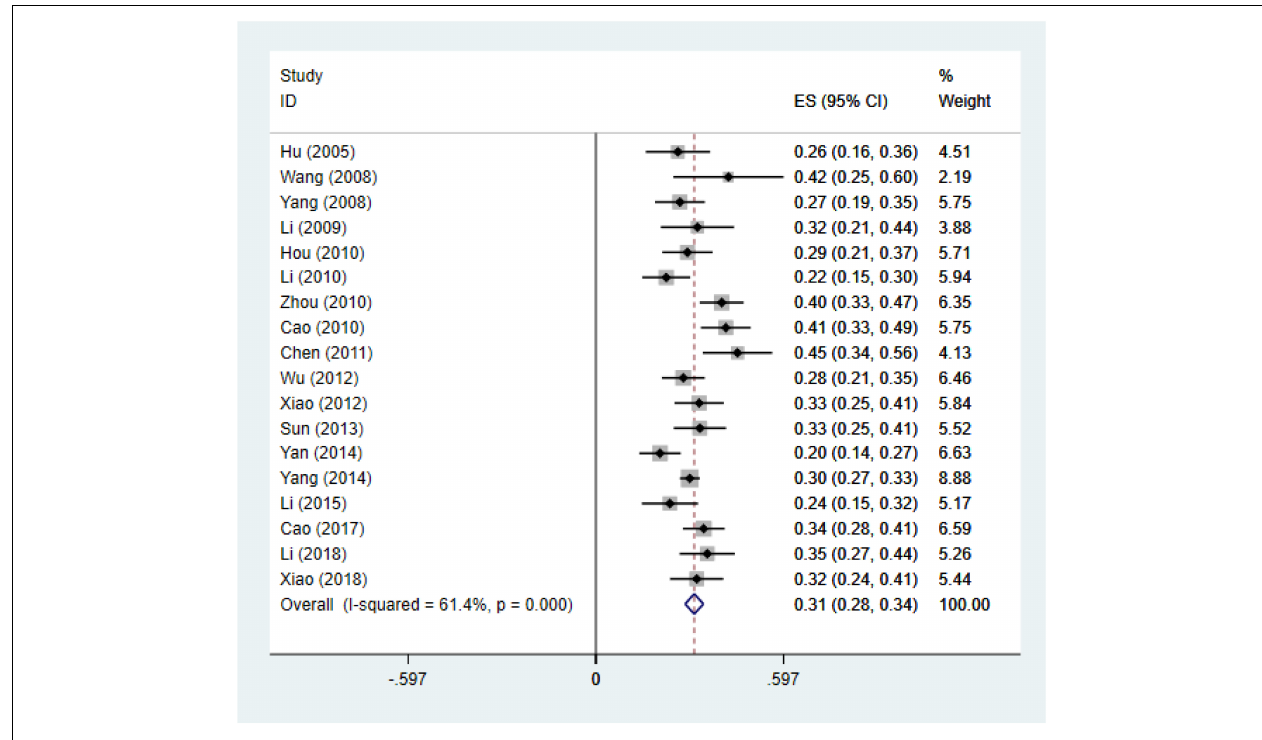
FIGURE 2 | Meta-analysis for the relationship between IAD and negative life events.